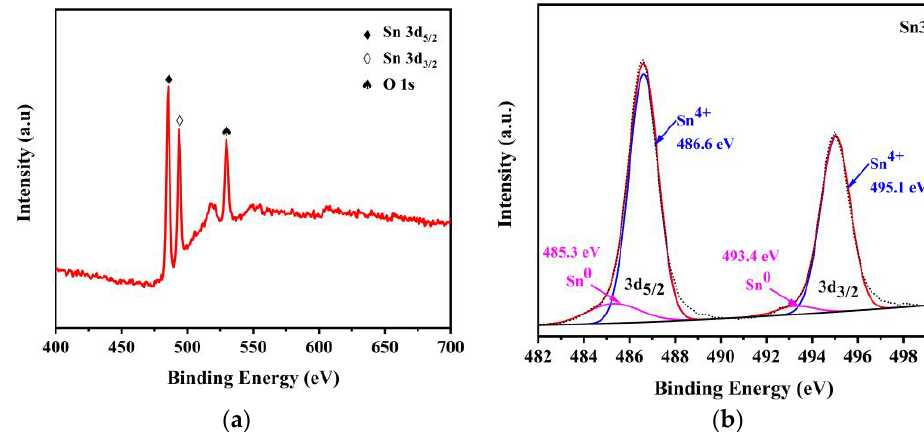
Figure 5. XPS spectrum of Sn/SnO 2 sample.